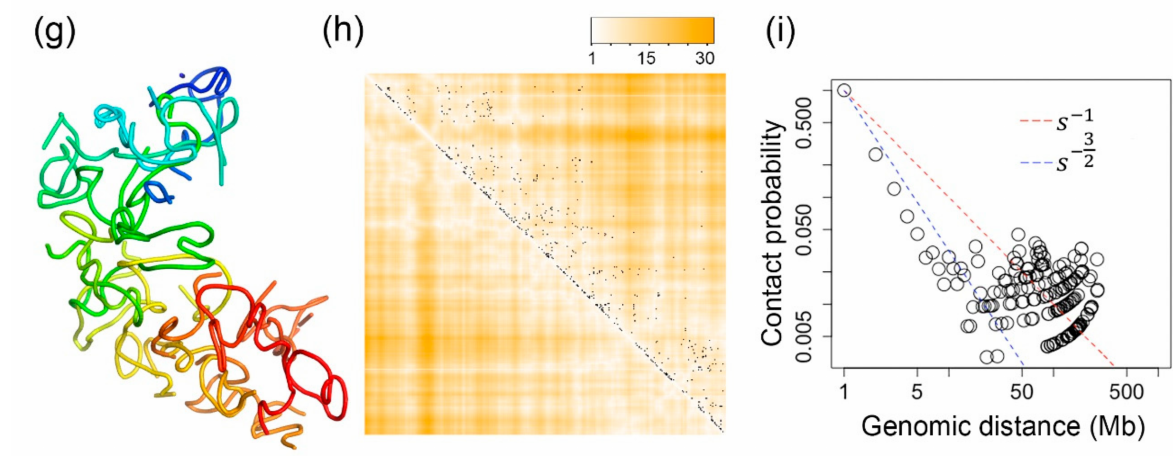
Figure 3. ( a – c ) The 3D structure of the X-chromosome of a TH1 cell that is inferred by our Lennard-Jones method and its evaluations. ( d – f ) The 3D structure of the X-chromosome of a TH1 cell that is inferred by SCL and its evaluations. ( g – i ) The 3D structure of the X-chromosome of a TH1 cell inferred by nuc_dynamics and its evaluations. ( a , d , g ) are the 3D structures inferred by our Lennard-Jones method, SCL, and nuc_dynamics. ( b , e , h ) Each black dot indicates one single-cell Hi-C contact. The darker orange color indicates higher Euclidean distances parsed from the inferred 3D structure, and the white color indicates small Euclidean distances parsed from the inferred 3D structure. ( c , f , i ) The contact probability of bead pairs over different values of genomic